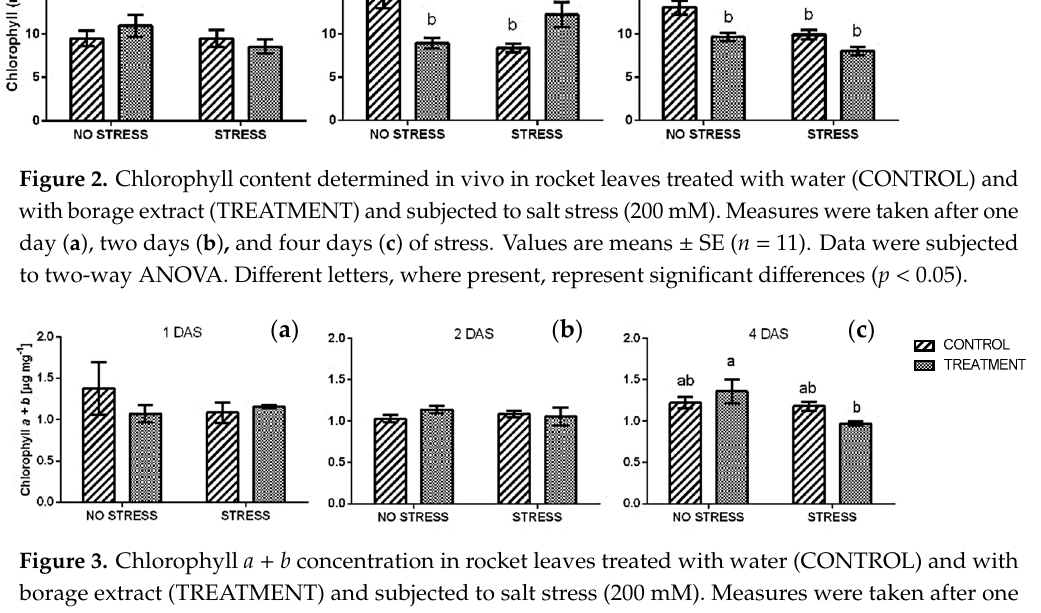
Figure 3. Chlorophyll a + b concentration in rocket leaves treated with water (CONTROL) and with borage extract (TREATMENT) and subjected to salt stress (200 mM). Measures were taken after one day ( a ), two days ( b ), and four days ( c ) of stress. Values are means ± SE ( n = 4). Data were subjected to two-way ANOVA. Different letters, where present, represent significant differences ( p < 0.05).